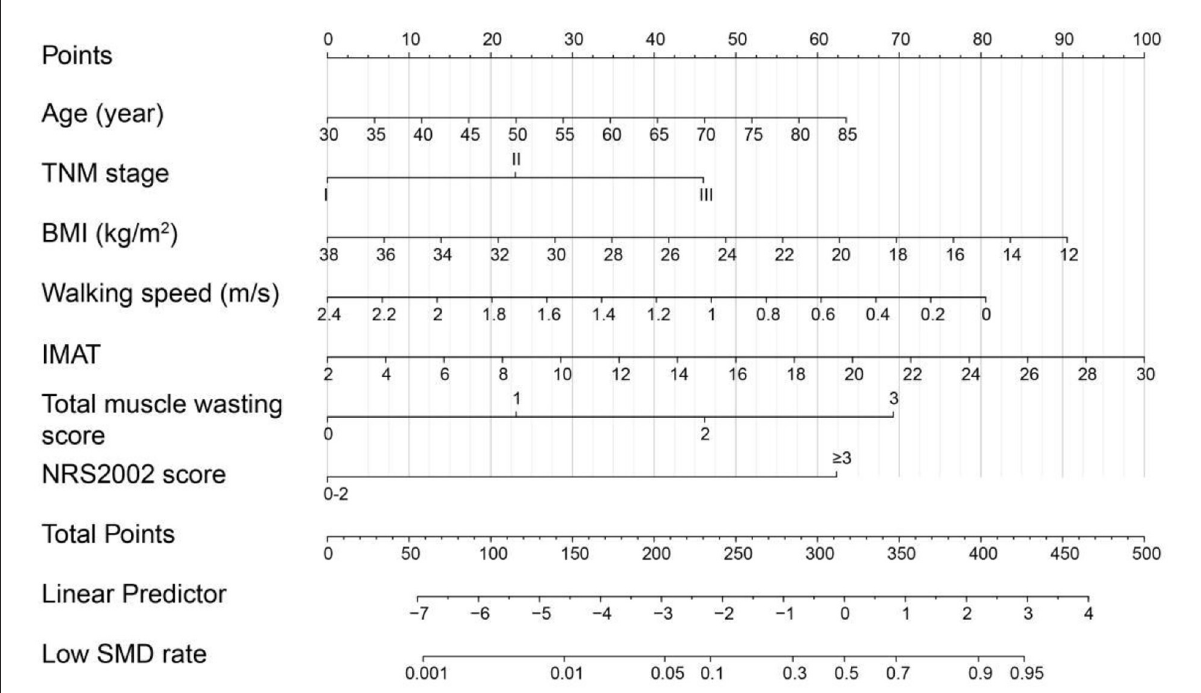
FIGURE2 The nomogram for predicting low SMD based on the training cohort ( n = 1,005).